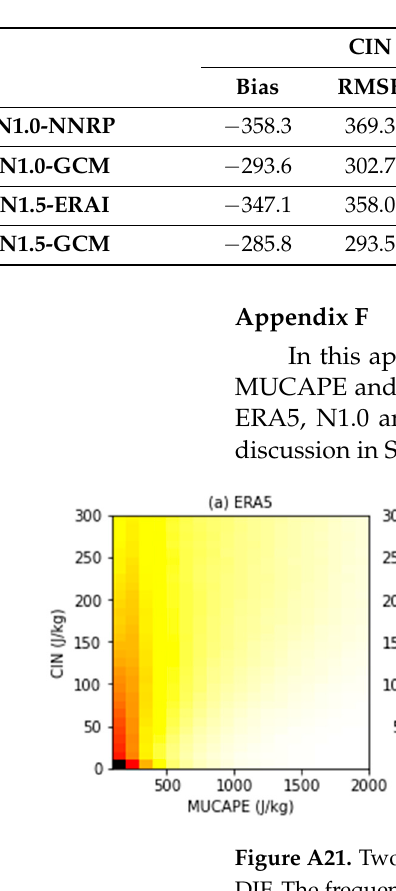
Figure A22. Interannual time series during 1990–2009 of the number of days with severe thunder- storm potential for ( a ) Spring, ( b ) Summer, ( c ) Autumn and ( d ) Winter from the land grid points of the d02 domain of ERA5 (black line), N1.0 (blue line) and N1.5 (red line).